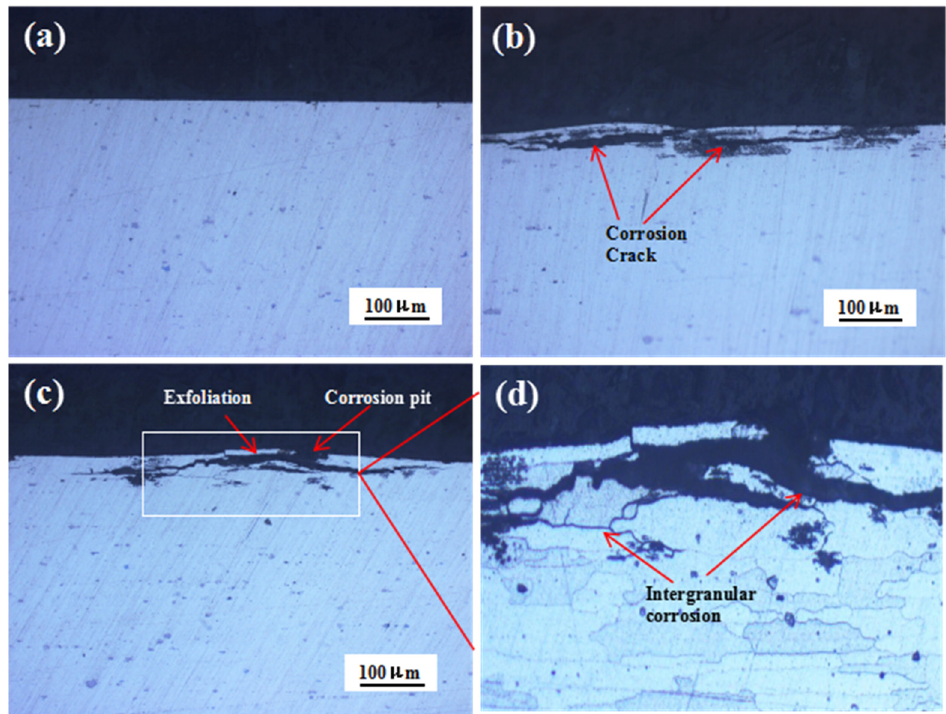
Figure 5. Cross-sectional morphologies of the 7075 alloy after outdoor exposure to the marine atmospheric environment at different time points: ( a ) 0 months, ( b ) 6 months, and ( c ) 12 months. ( d ) Magnified image of the white rectangle in ( c ).